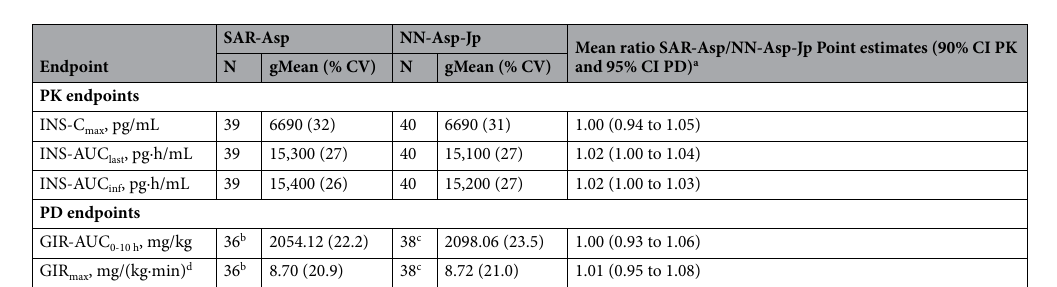
Table 2. Primary and secondary pharmacokinetic and pharmacodynamic endpoints. % CV percent coefficient of variation, CI confidence interval, GIR body weight standardized glucose infusion rate, GIR-AUC 0–10 h area under the body weight-standardized GIR rate vs time curve from 0 to 10 h, GIR max maximum smoothed body weight standardized GIR gMean geometric mean, INS-AUC last area under the drug plasma concentration– time curve from time 0 to the time of the last quantifiable data point, INS-AUC inf area under the drug plasma concentration–time curve from time 0 to infinity, INS-C max maximum insulin aspart concentration in plasma, PD pharmacodynamic, PK pharmacokinetic. a 90 and 95% CI for the pairwise treatment ratios. b Clamp data from 3 subjects in Period 2 were excluded due to operational errors with the device. c Clamp data from 3 subjects in Period 2 were excluded due to operational errors with the device. d GIR max determined from smoothed GIR data (LOESS method, tension